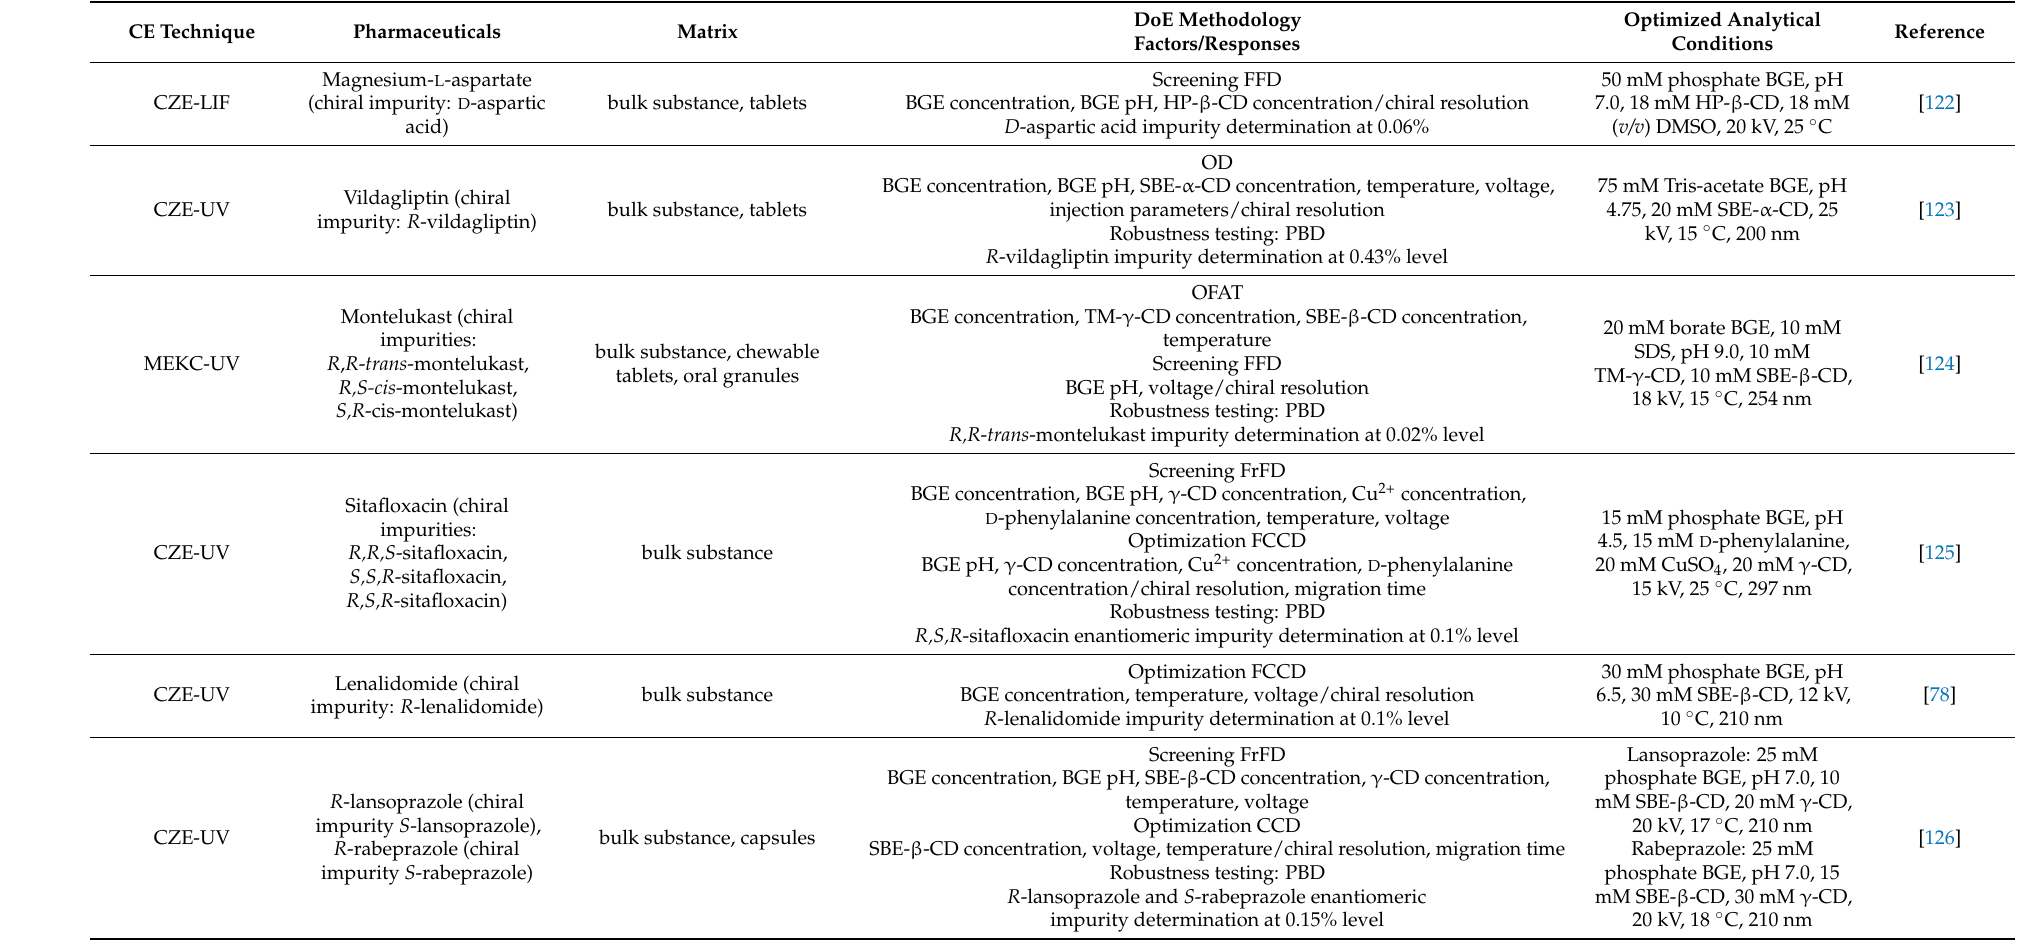
Table 1. CE methods for the chiral purity analysis of pharmaceuticals optimized by using DoE